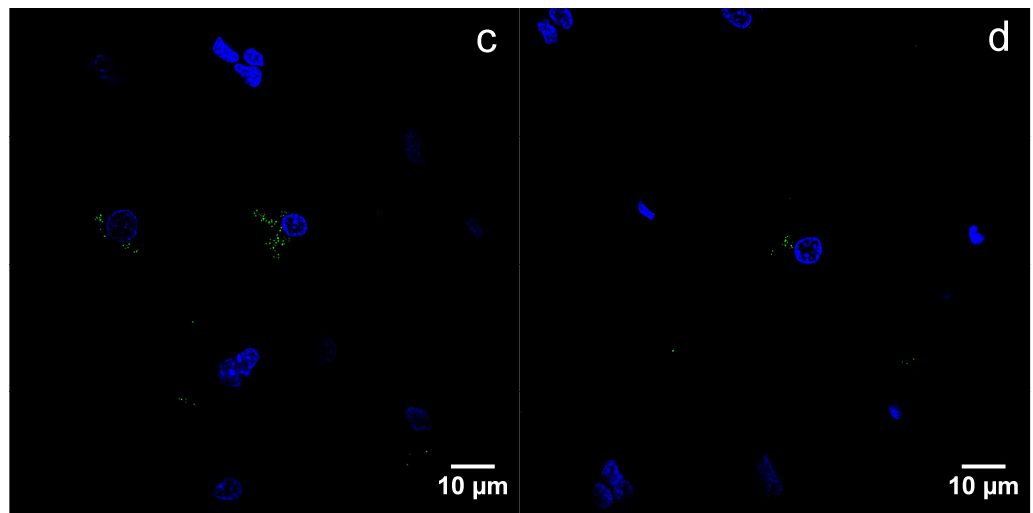
Figure 4. Detection of viral capsid antigens by immunofluorescence, confocal microscopy, DAPI—blue, B19V-immunopositive products—green: ( a ) B19V-positive oligodendrocytes and neurons in the gray matter of the UEP subject (frontal lobe, 1000 × ), the insert shows magnified view of the oligodendrocyte; ( b ) B19V-positive oligodendrocytes in the white matter of the UEP subject (frontal lobe, 1000 × ); ( c ) B19V-positive oligodendrocytes in the gray matter of the UEP subject (temporal lobe, 1000 × ); ( d ) B19V-positive oligodendrocyte in the white matter of the UEP subject (temporal lobe, 1000 ×